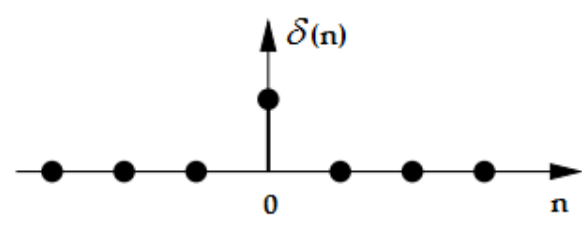
Figure 6. Unit impulse or unit sample.